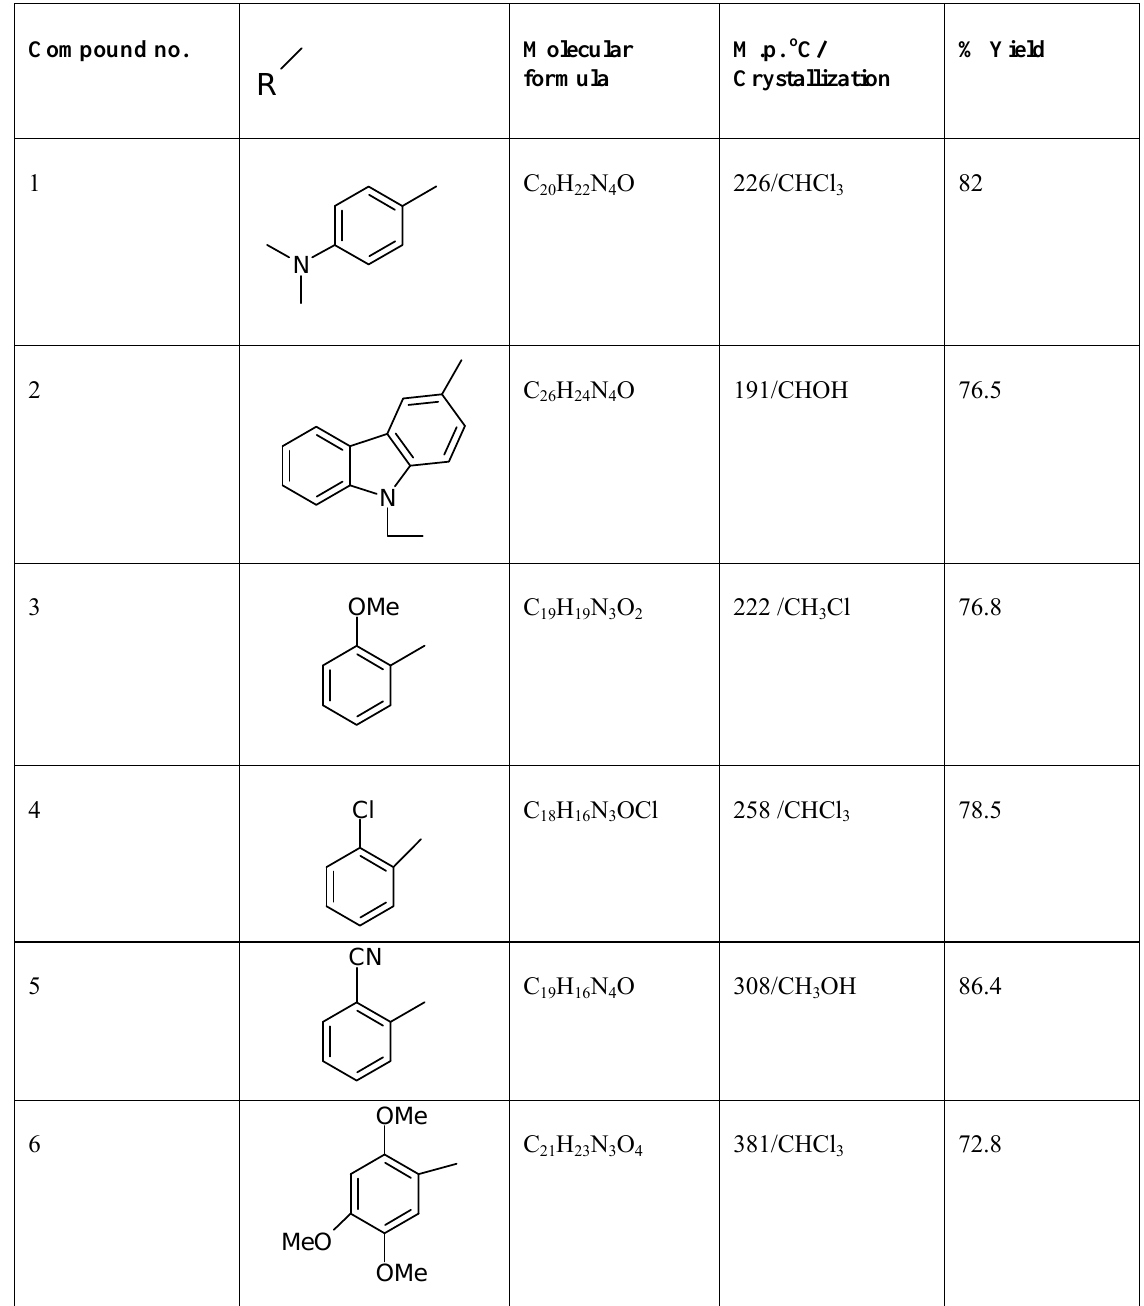
Table 1. Physicochemical data of the synthesized compounds. Compound